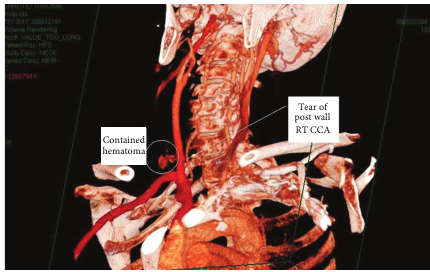
F 4: CTA demonstrating injury of the carotid artery with a tear and contained hematoma in the surrounding